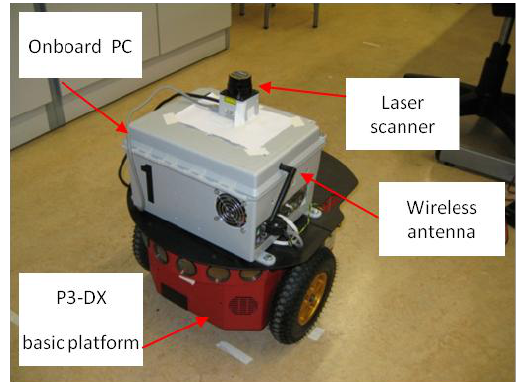
Figure 1. One of the P3-DX robotic platforms equipped with encoders and laser scanner for the platoon guidance